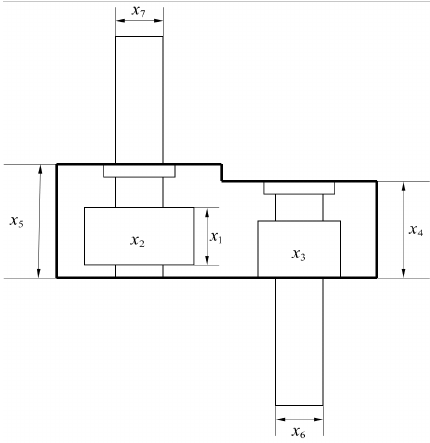
Figure 6. Speed reducer design problem. Table 13. Results of the compared algorithms for solving the speed reducer design